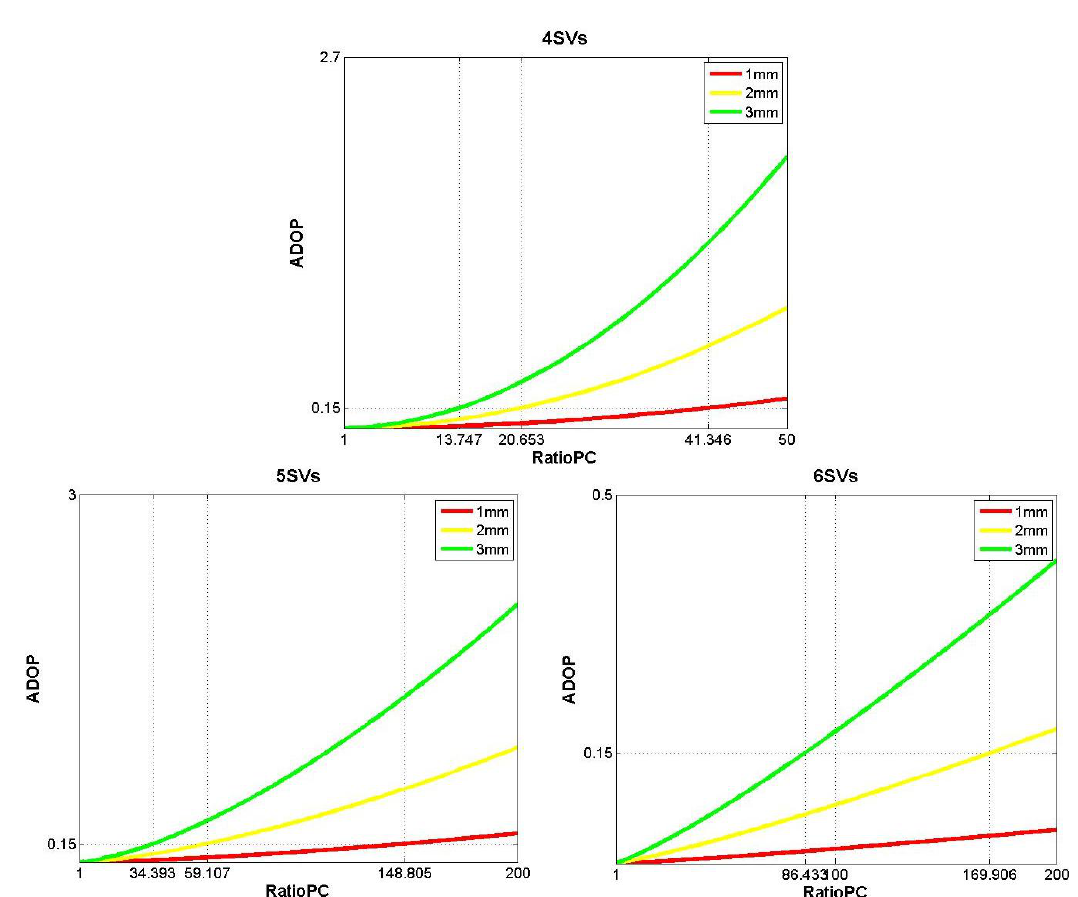
ADOP when the number of available satellites equals four, Figure 2. The variation of SF/SE five and six, respectively.